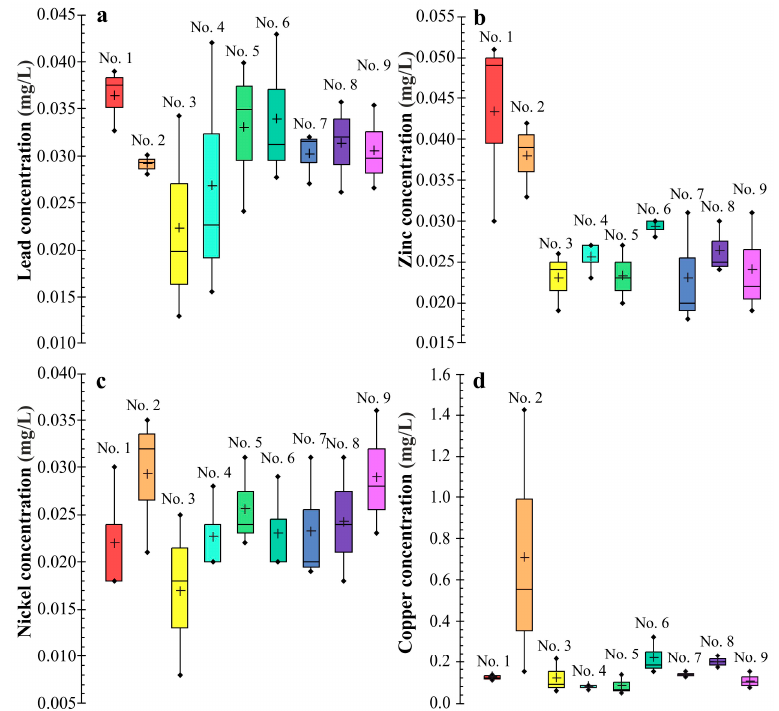
Figure 6. Boxplots showing the median, quartiles, and minimum and maximum values of quality parameters in the samples: ( a ) lead; ( b ) zinc; ( c ) nickel; and ( d ) copper concentration.